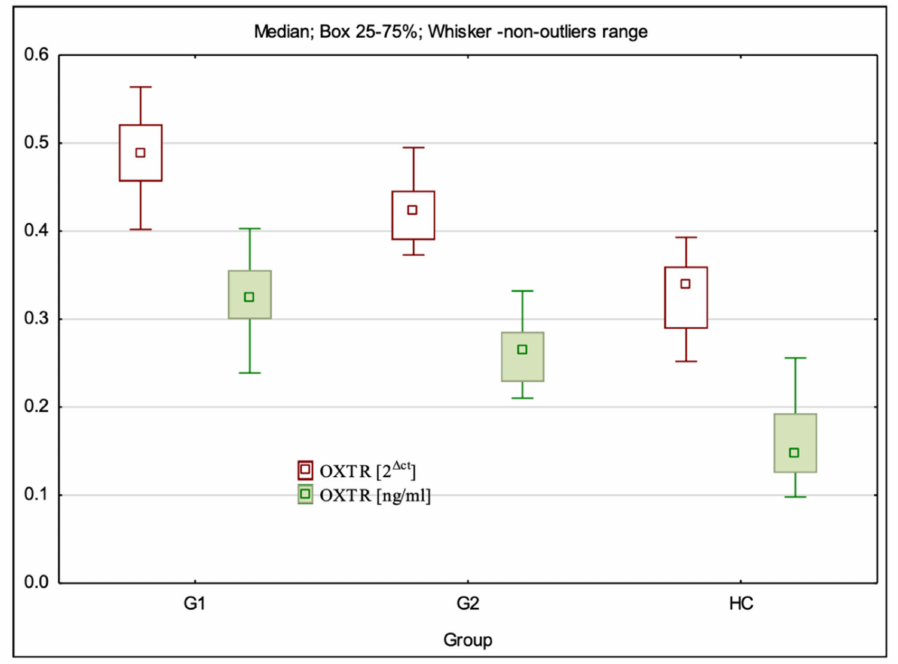
Figure 2. OXTR gene expression at the mRNA and protein levels in the studied